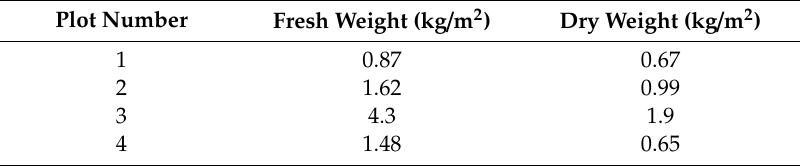
Table 2. Fine fuel loads in di ff erent plots with advance regeneration in a slash pine plantation. Plot